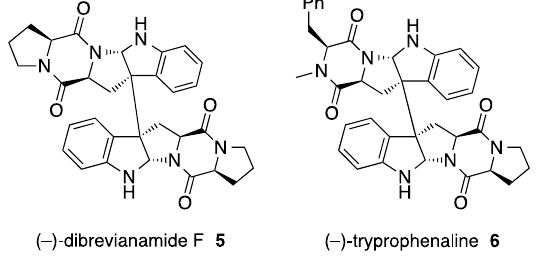
Figure 5. Chemical structures of the newly formed compounds, (–)-dibrevianamide F 5 and (–)-tryprophenaline 6 [9].